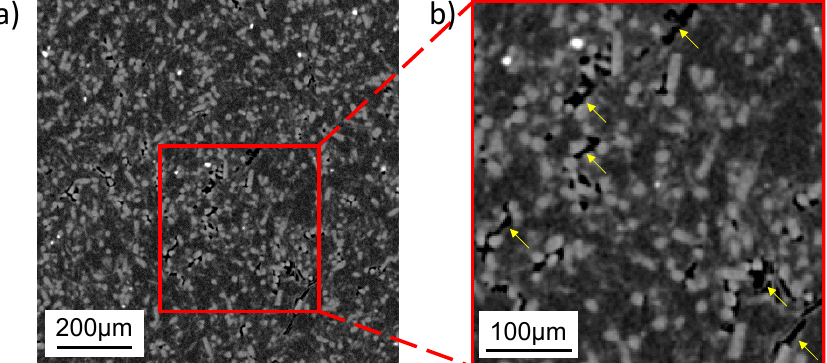
Figure 2. The representative X-ray micro-tomographic slice of the GFRPTFE specimen ( a ) Low magnification image and ( b ) high magnification